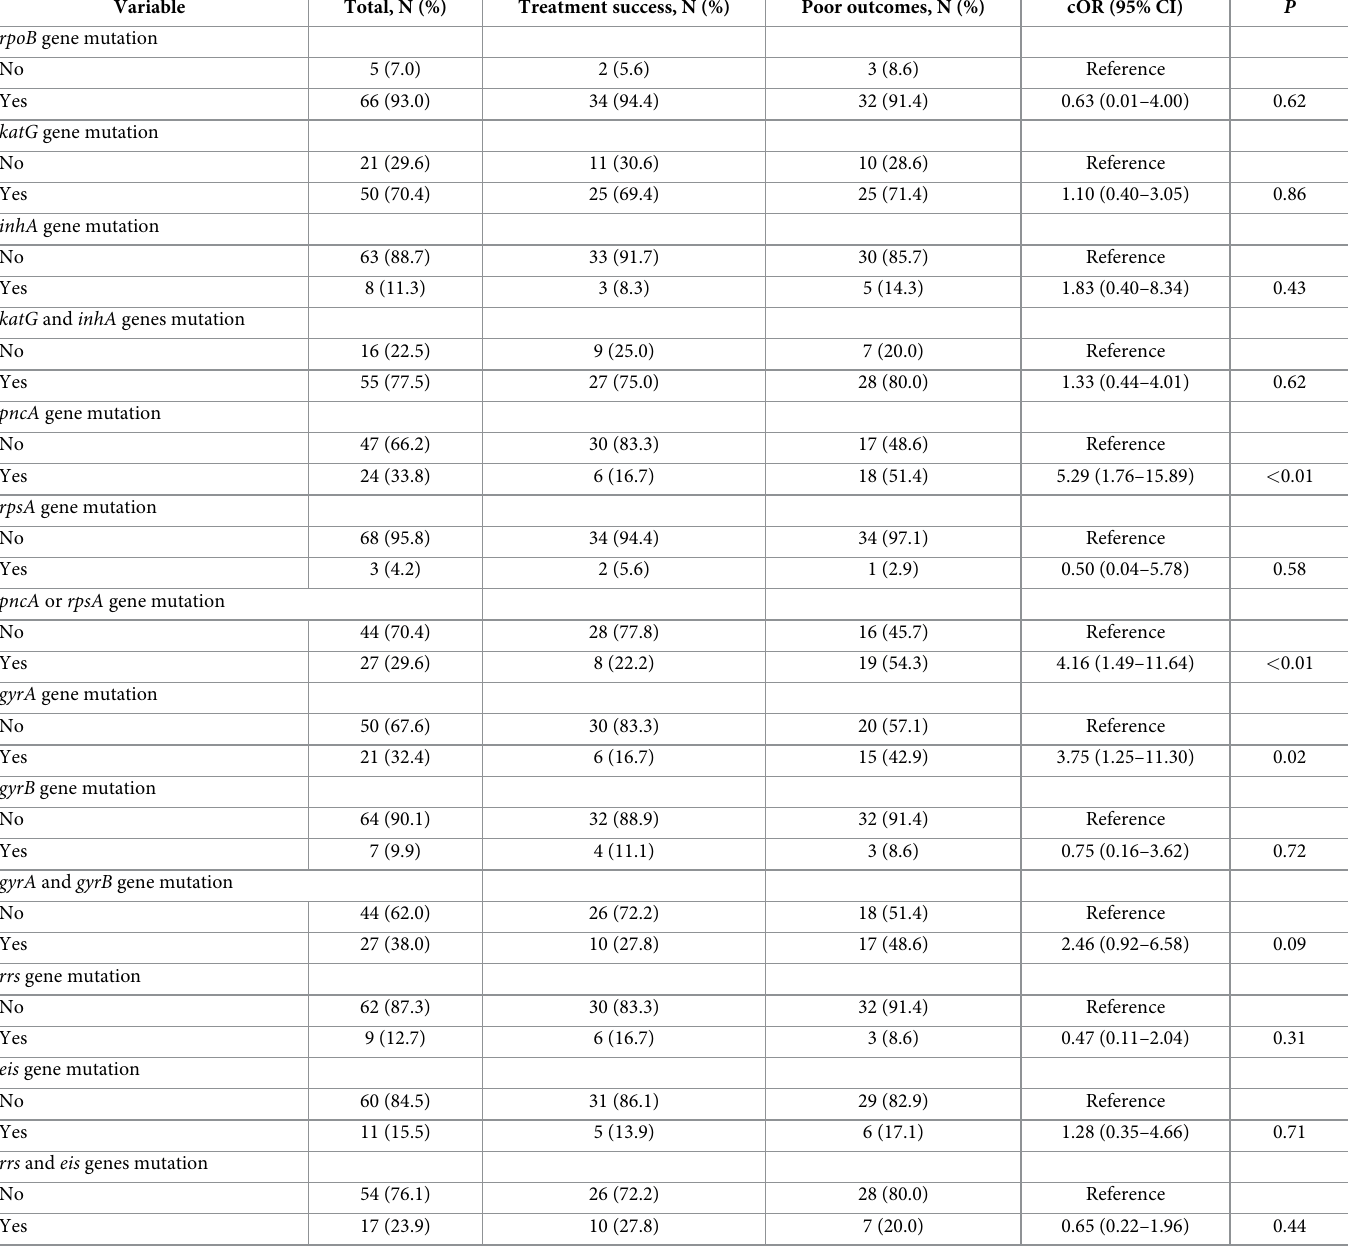
Table 4. Univariable logistic regression analysis of drug resistance gene mutations associated with treatment outcomes. Variable Total, N (%) Treatment success, N